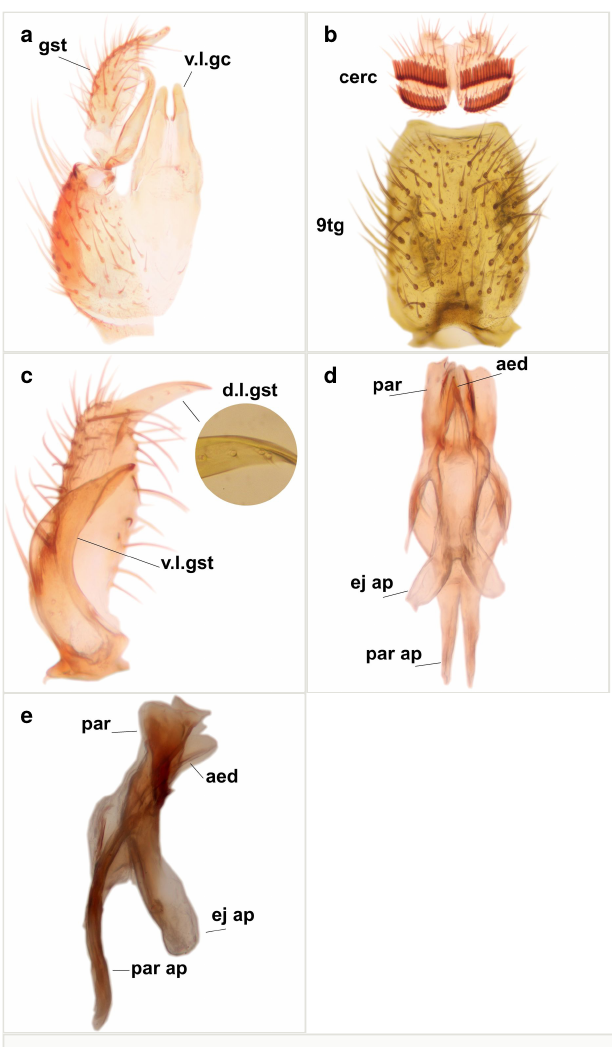
Figure 9. Boletina norokorpii Salmela & Kolcsár sp.n., holotype male, hypopygium. a : Hypopygium, ventral view. vl gc=ventral lobe of gonocoxites, gst=gonostylus. b : Cerci (cerc) and 9th tergite (9tg), dorsal view. c : Gonostylus, lateral view. d.l.gst=dorsal lobe of gonostylus, v.l.gst=ventral lobe of gonostylus. d : Aedeagal complex, dorsal view. aed=aedeagus, par=parameres, par ap=parameral apodemes, ej ap=ejaculatory apodemes. e : Aedeagal complex, lateral